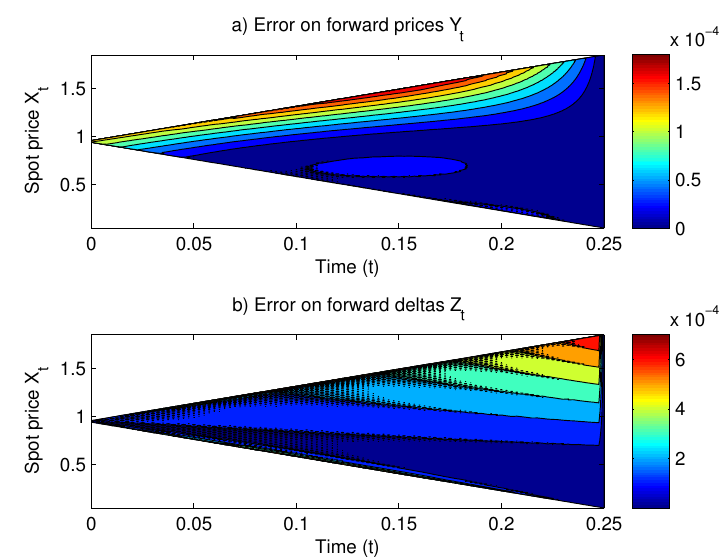
Figure 5. Contour plot of errors using the 2-stage Runge–Kutta scheme. The numerical solution is obtained on a time mesh with n = 100 time steps and returns an forward price of 1.0121 and initial value of 0.0453 for the control process. The exact values are 1.0123 and 0.0452,